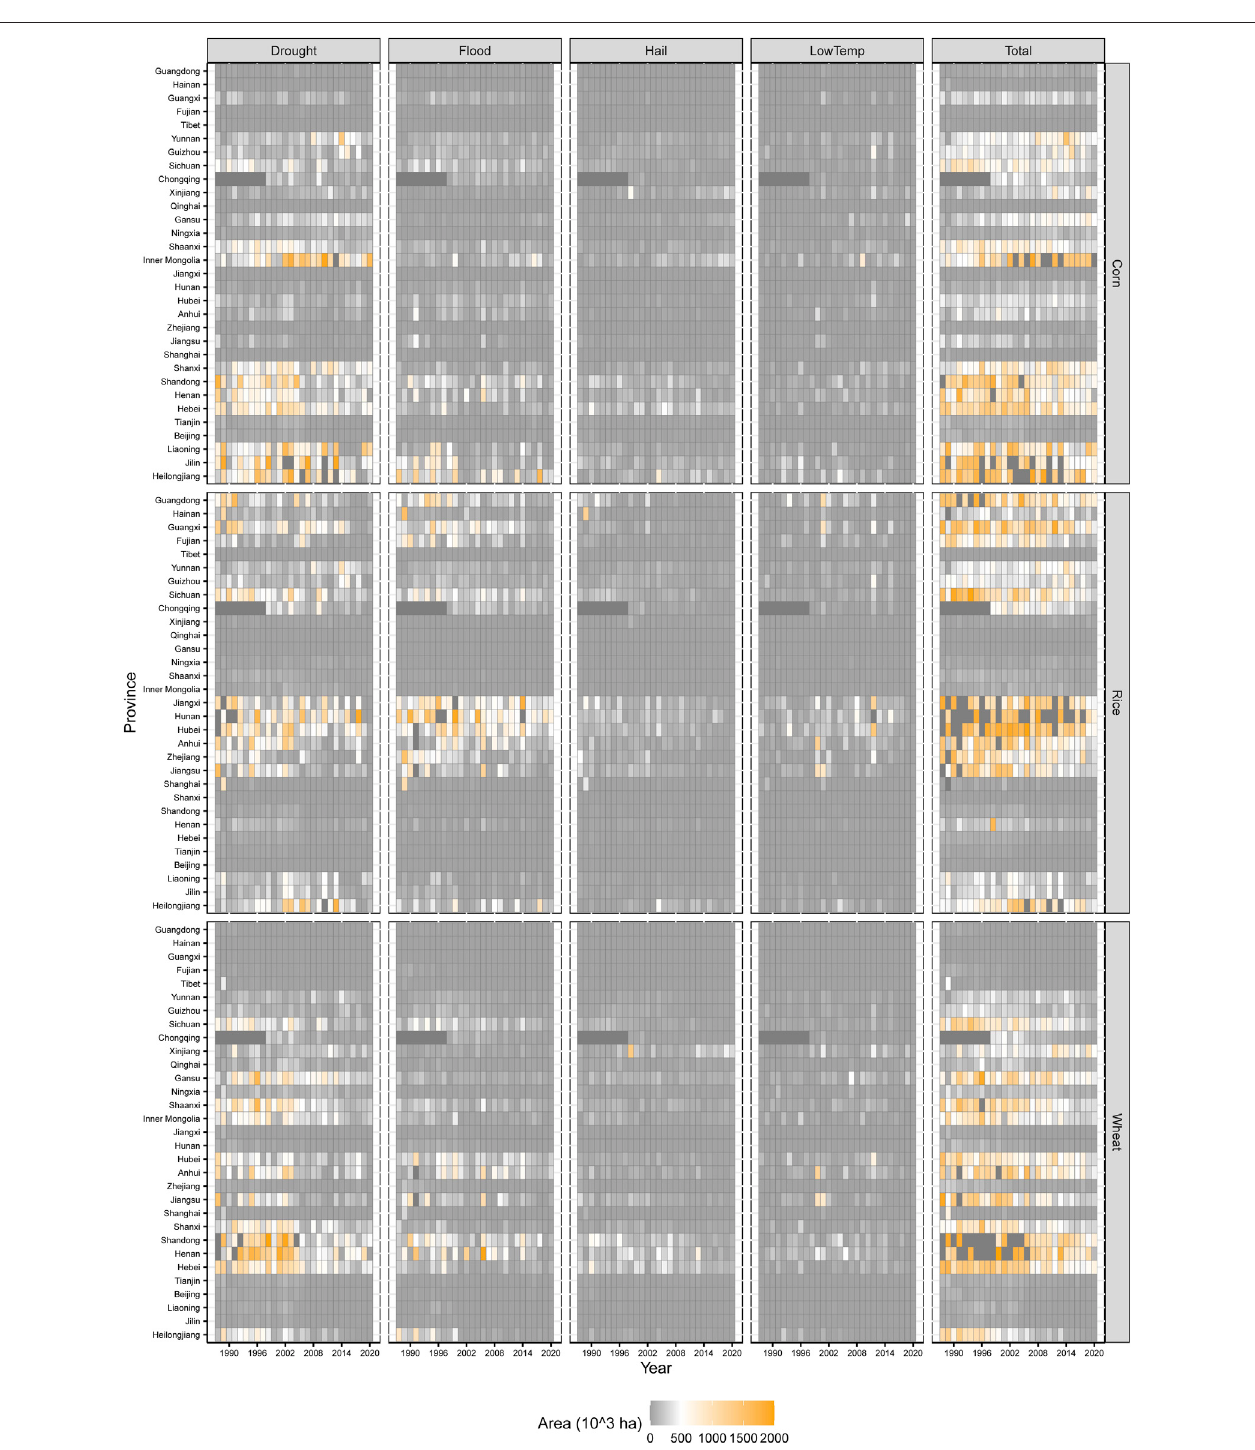
FIGURE 5 | Changes in the area affected by different mild natural disasters for rice, maize, and wheat in each province from 1988 to 2020.